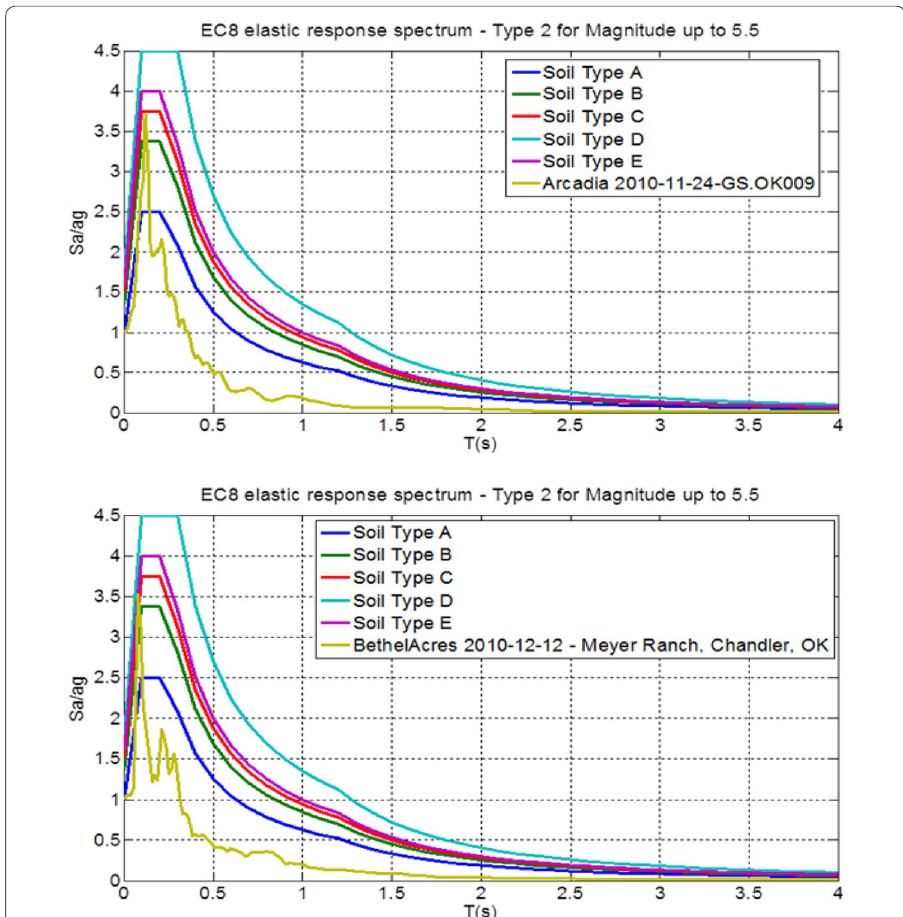
Fig. 8 Elastic response spectra of the induced seismic ground motions obtained from the PEER database and their comparison with the Eurocode 8 type 2 elastic response spectrum for magnitudes up to 5.5. In the legend, the soil types A–E (rock [A] to softer soils [E]) refer to the different Eurocode 8 type 2 elastic response spectra produced for different soil conditions according to Eurocode 8. The remaining term in the legend refers to the name of the seismic station (PEER database) which recorded the induced seismic event’s (Arcadia, BethelAcre, Table 1) ground motion used to produce the elastic response